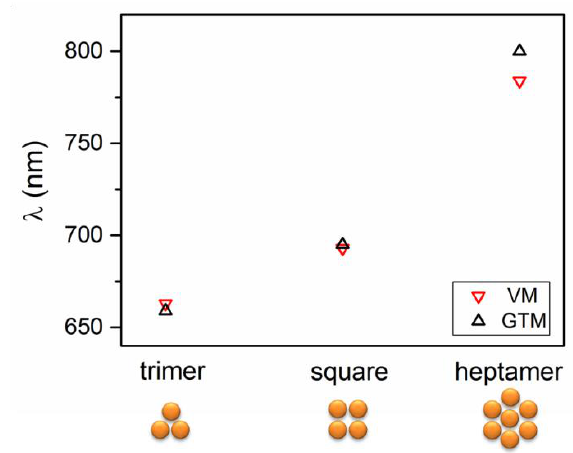
Figure 7. Comparison of results of the present work and Reference [37] in the case of triangle, square, and heptamer clusters. Input data have been estimated from Reference [37] and are ω 0 = 2.15 eV and β = −0.28 eV.